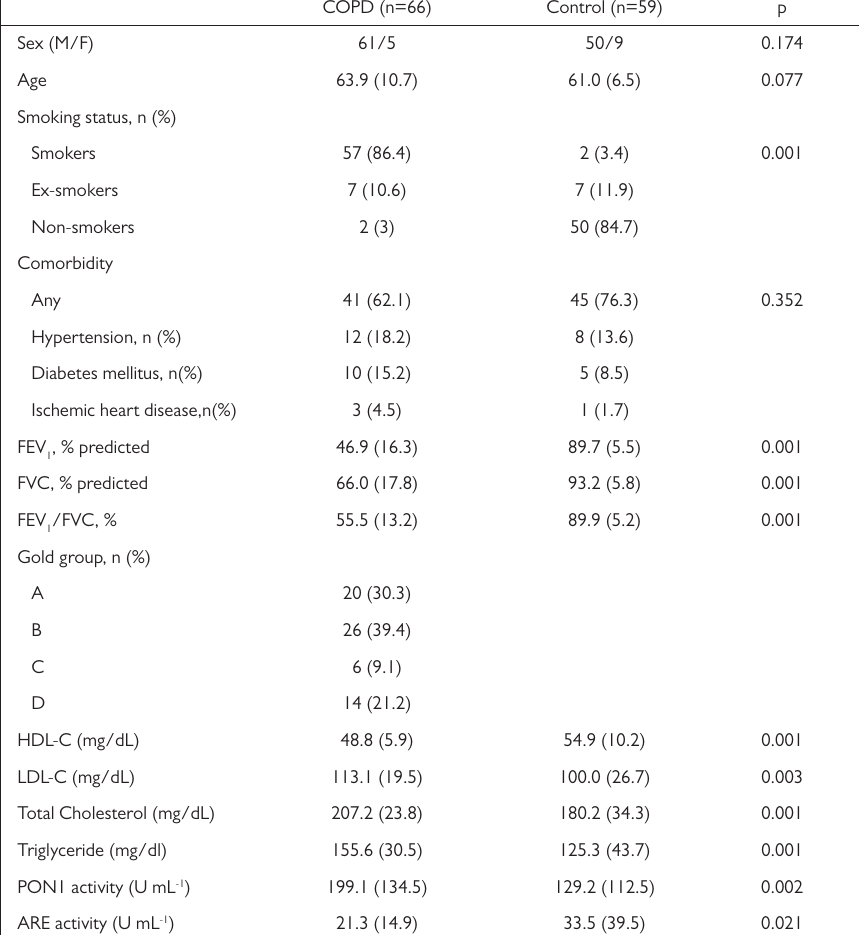
Table 1. Clinical, functional and biochemical parameters of